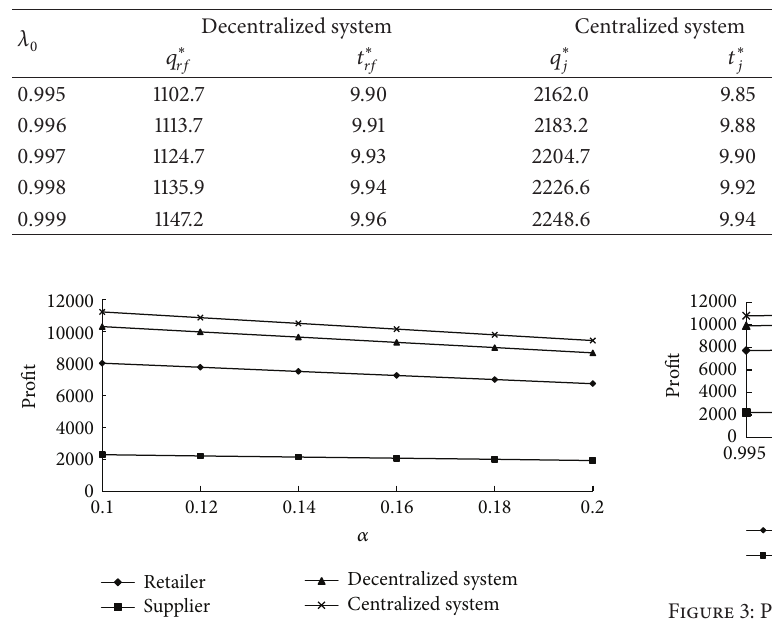
Table 4: Optimal decisions in each supply chain system with freshness factor 𝜆 0 .